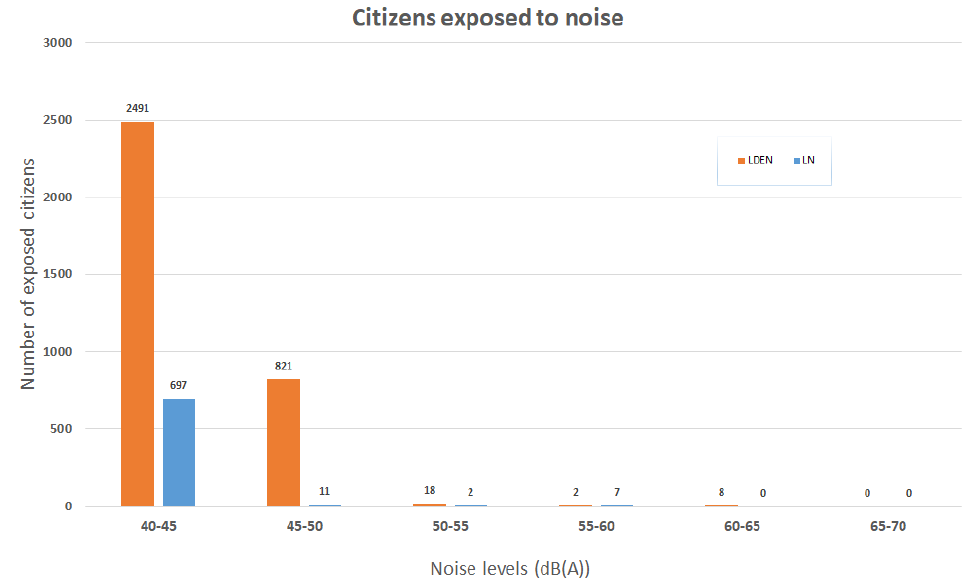
Figure 6. L N noise contours map for Scenario 1 (present).